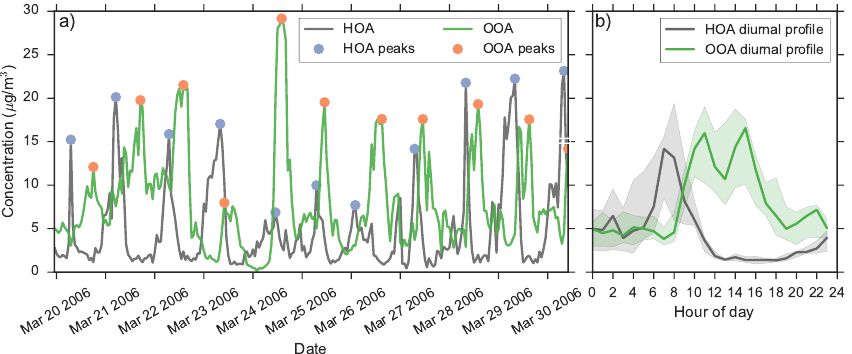
Figure 1. (a) Time series of HOA (dark gray) and OOA (green) concentrations measured at the T0 site in Mexico City during the MILAGRO field campaign (Aiken et al., 2009). Blue and orange circle markers indicate the daily HOA and OOA peaks, respectively, used for the peak reproduction analysis (Sect. 4). (b) Diurnally averaged HOA and OOA concentrations.